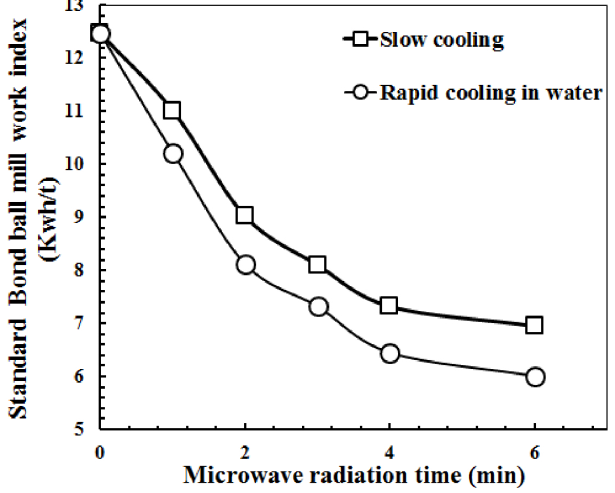
Fig. 4. Effect of microwave radiation time on standard Bond ball mill work